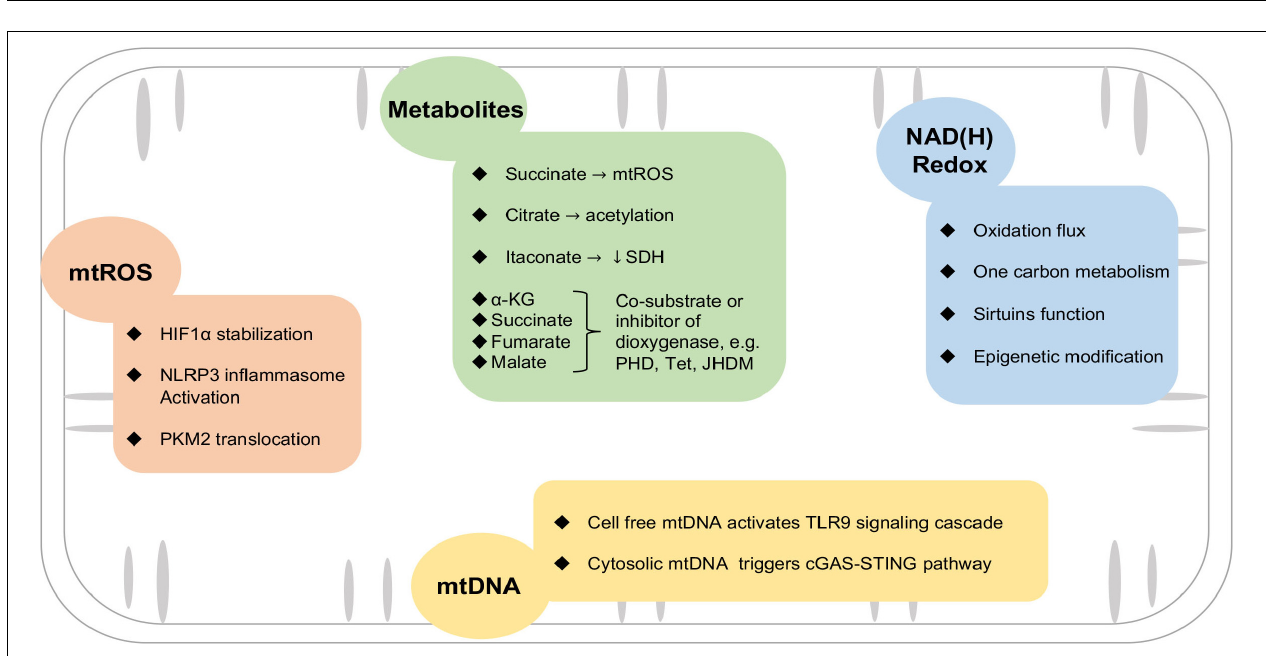
FIGURE 2 | Mitochondrial mechanisms involved in macrophage activation. Mitochondria provide triggers and mediators of the inflammatory response in macrophages via mtROS, metabolites, NAD(H) redox balance, and leakage of mtDNA. See text for details. HIF1 α , hypoxia-inducible factor 1 α ; SDH, succinate dehydrogenase; NLRP3, nod-like receptor family pyrin domain containing 3; cGAS-STING, GMP-AMP synthase/stimulator of interferon genes; PKM2, pyruvate kinase M2; JHDM, Jumonji domain-containing histone demethylase; PHD, prolyl hydroxylases; Tet, T5-methylcytosine hydroxylases.